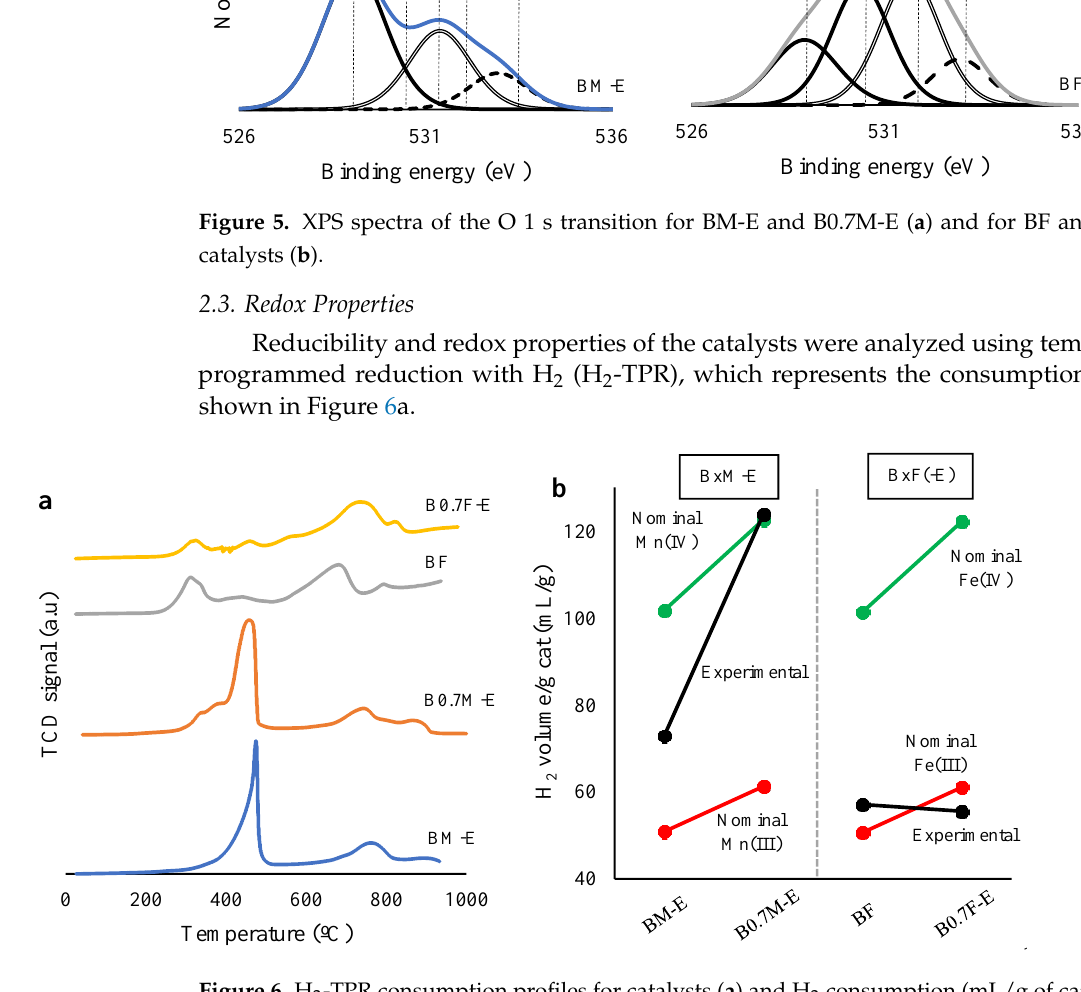
(i) a low-temperature peak, which appears between 400 ◦ C and 500 ◦ C, assigned to